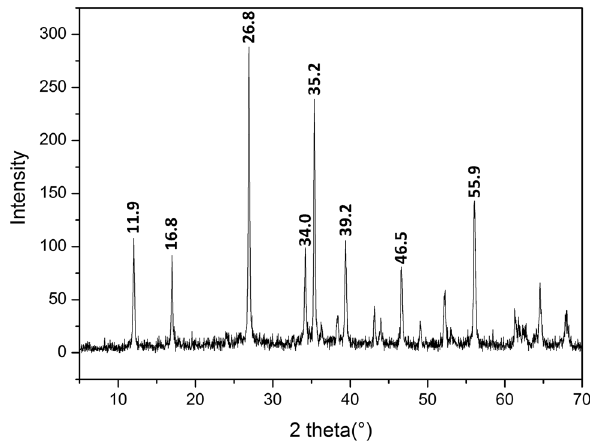
Figure 1. XRD diffractogram collected from synthesized akaganeite.